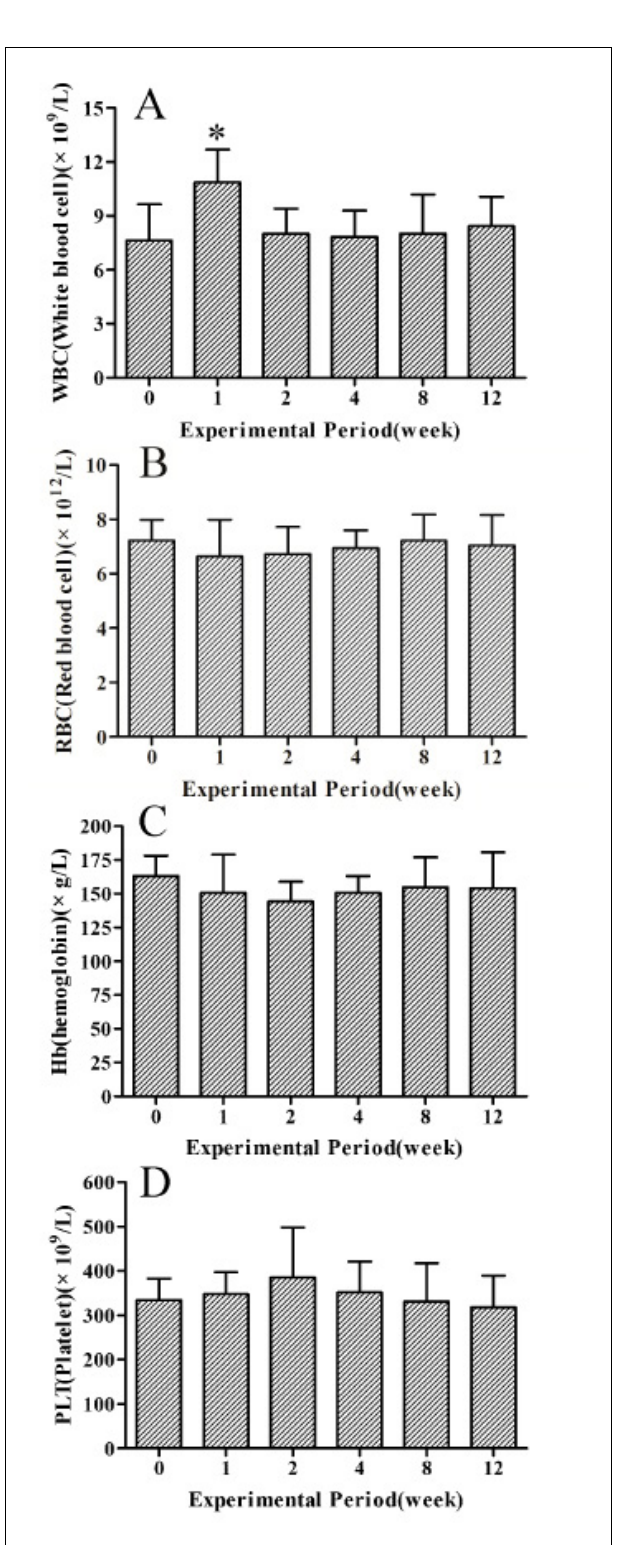
Fig. 3 - Blood routine indexes at pre- and 1, 2, 4, 8 and 12 weeks after implantation. Panels A-D show changes of WBC counts, RBC counts, Hb levels and PLT counts, respectively. *Donate significant difference (P<0.05). Data are the means ± SEM (n=9).